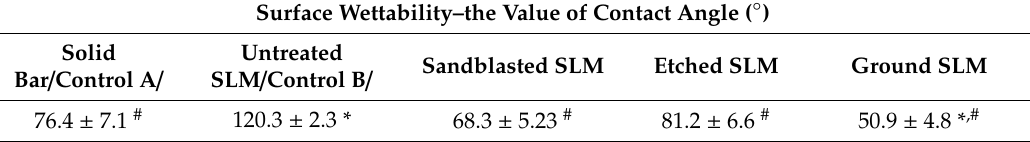
Table 3. Surface wettability of the investigated surface-modified titanium alloy specimens determined by the measurements of the contact angle of distilled water (n = 5; data are the means ± SD; * significantly different from control A (p < 0.05); # significantly different from control B (p < 0.05)).